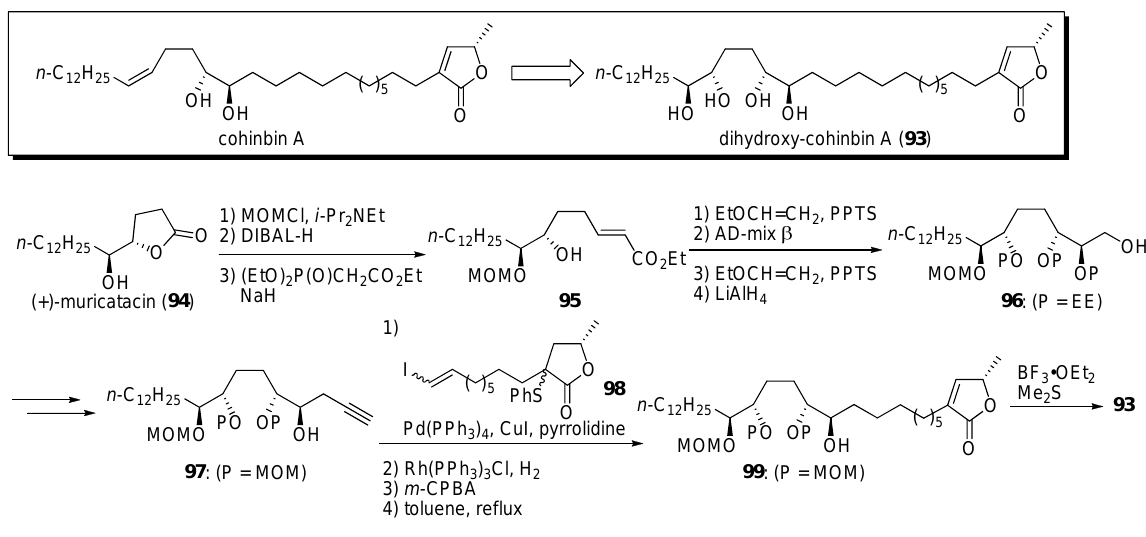
Table 7. Summary of the inhibitory potencies (IC